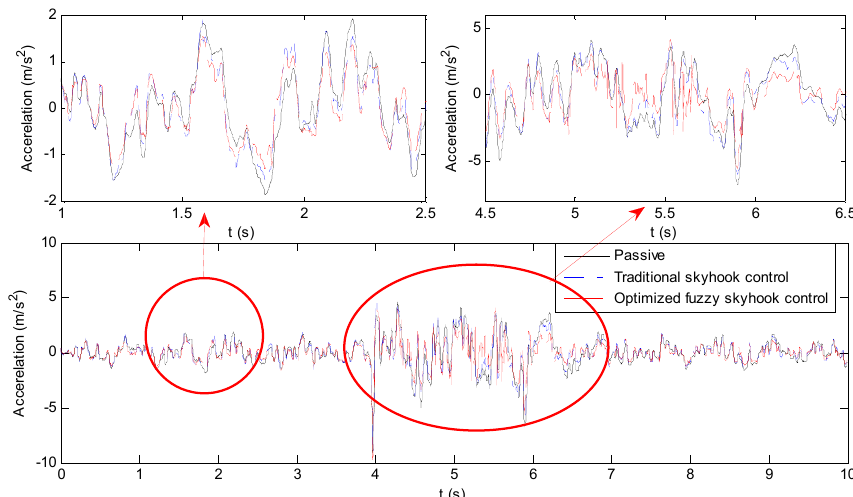
Figure 20. Comparison of the body vertical acceleration using the three control methods under potholed road excitation.